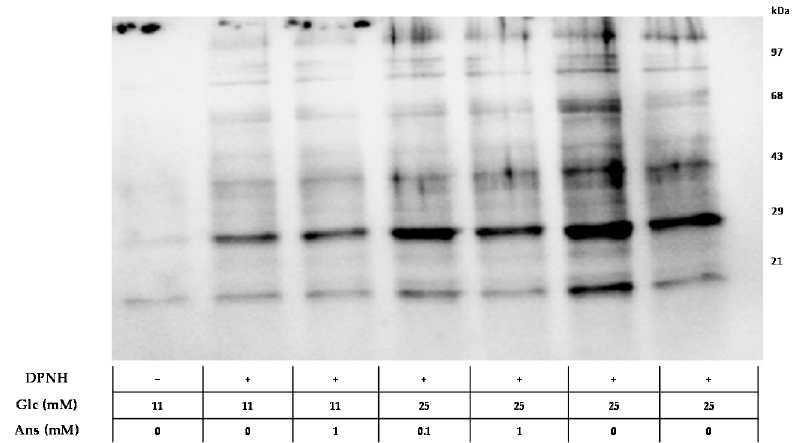
Figure 2. Effect of co-incubation with glucose and anserine in human tubular cells (HK-2) on total protein carbonylation. Glucose stress (25 mM) increased total protein carbonylation in HK-2 cells, compared to cells incubated under normal glucose concentration (11 mM; n = 3). Co-incubation with anserine (0.1 and 1 mM) reduced protein carbonylation. In unstressed cells, anserine had no effect on overall protein carbonylation. Protein carbonylation was visualized by derivatization with 2,4-dinitrophenolhydrazine (DNPH) and quantified immunochemically.